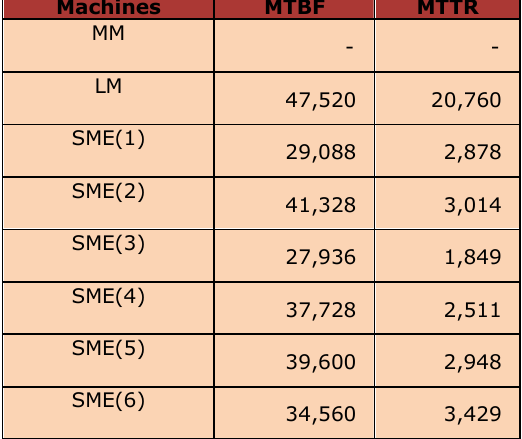
Table 2. MTBF and